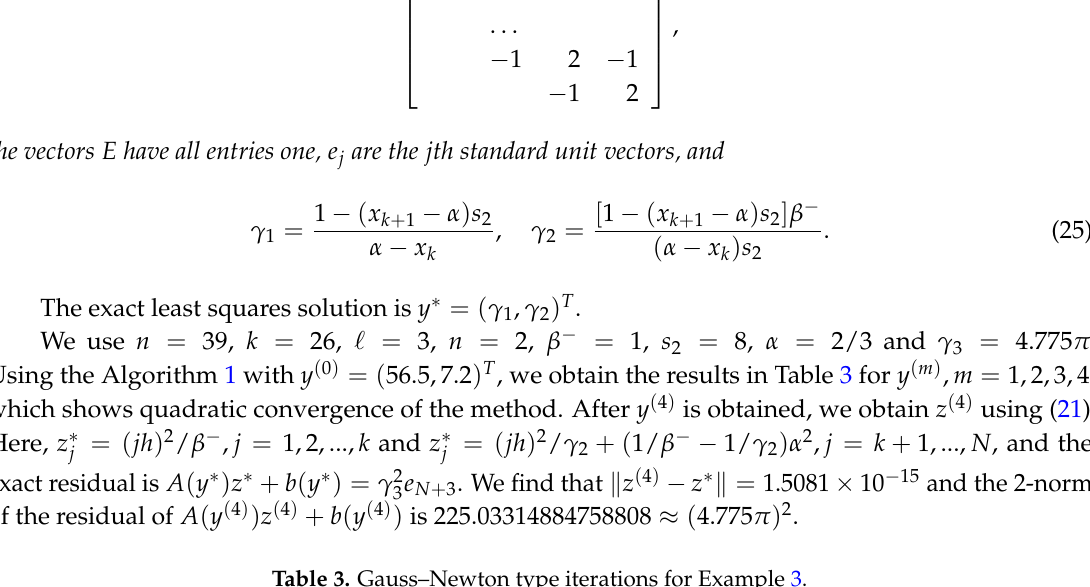
Table 3. Gauss–Newton type iterations for Example